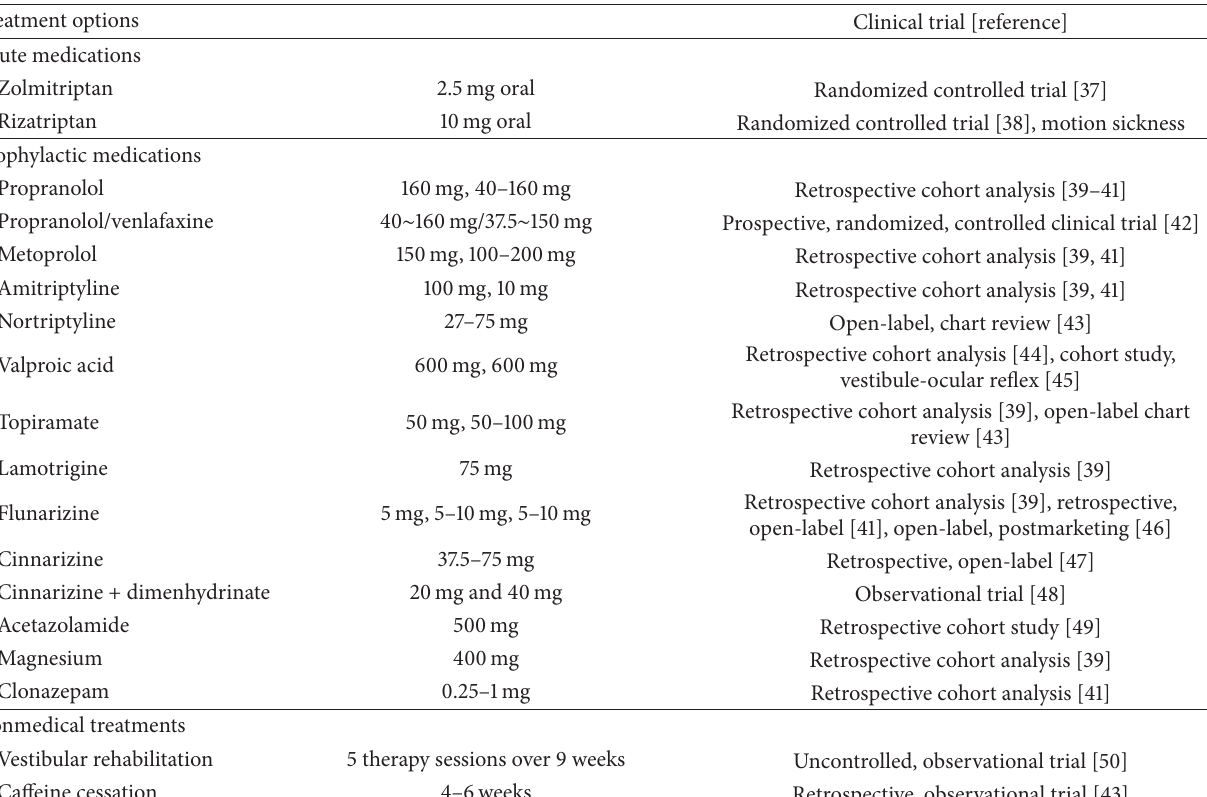
Table 1: Treatment options for